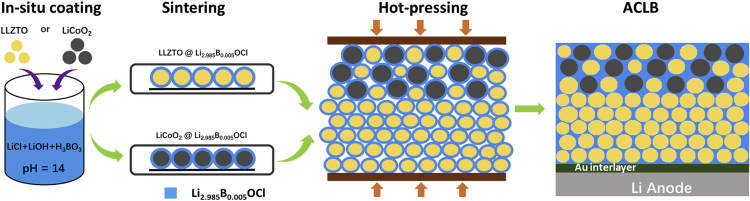
Schematic Diagram of Surface Coating of Li2.985B0.005OCl and Assembling of ACLB